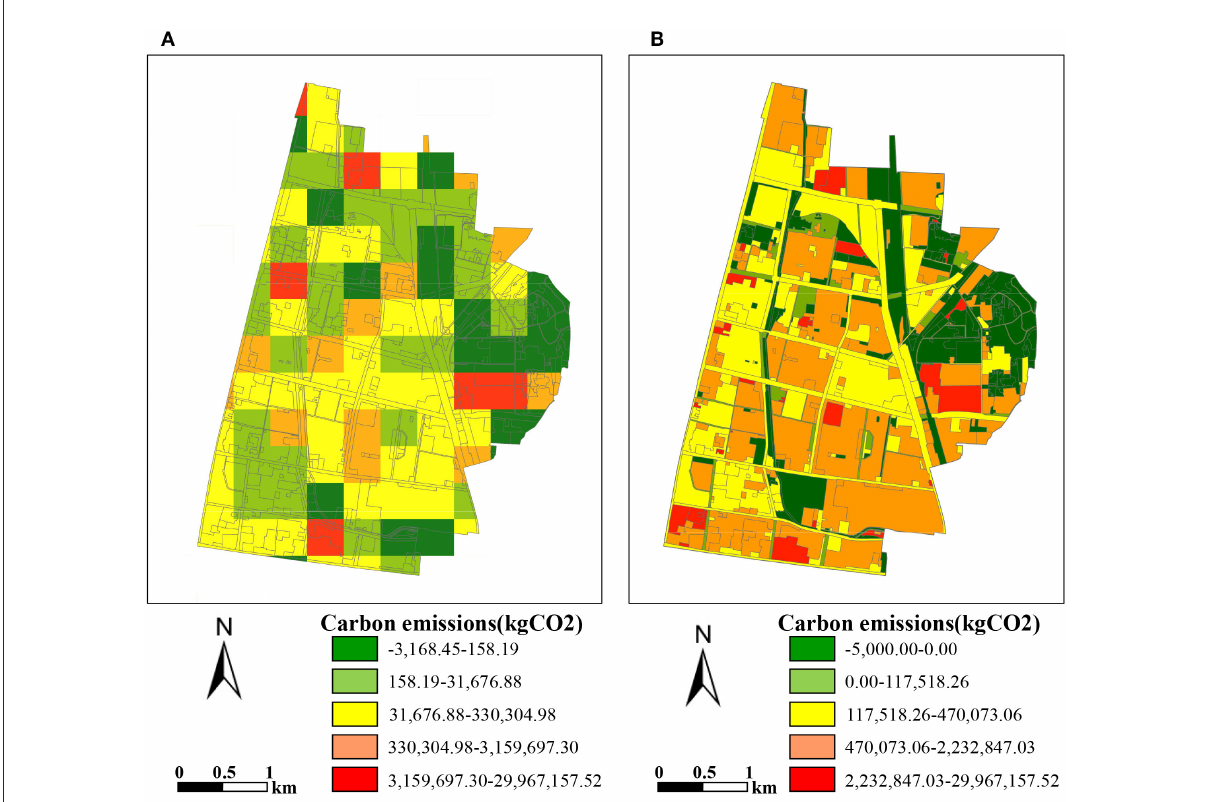
FIGURE7 Comparison of the carbon emissions mapping results with other method. (A) Gridded carbon emissions map with 300 carbon emissions map of this study.